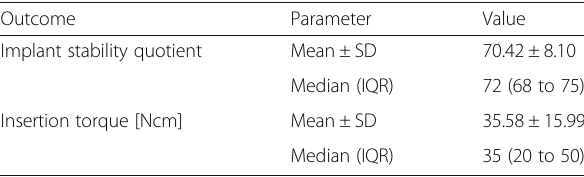
Table 3 Descriptive statistics for the different outcomes of the implant biomechanical parameters ( n = 62 implants) Outcome